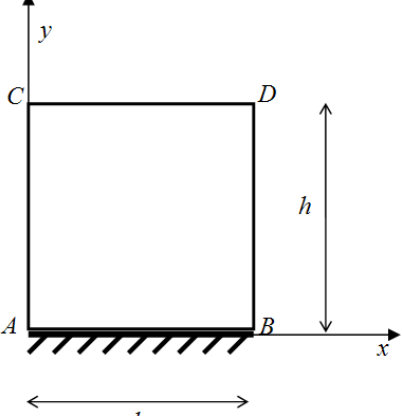
Figura 4: Pannello rettangolare vincolato tramite interfaccia ad un corpo